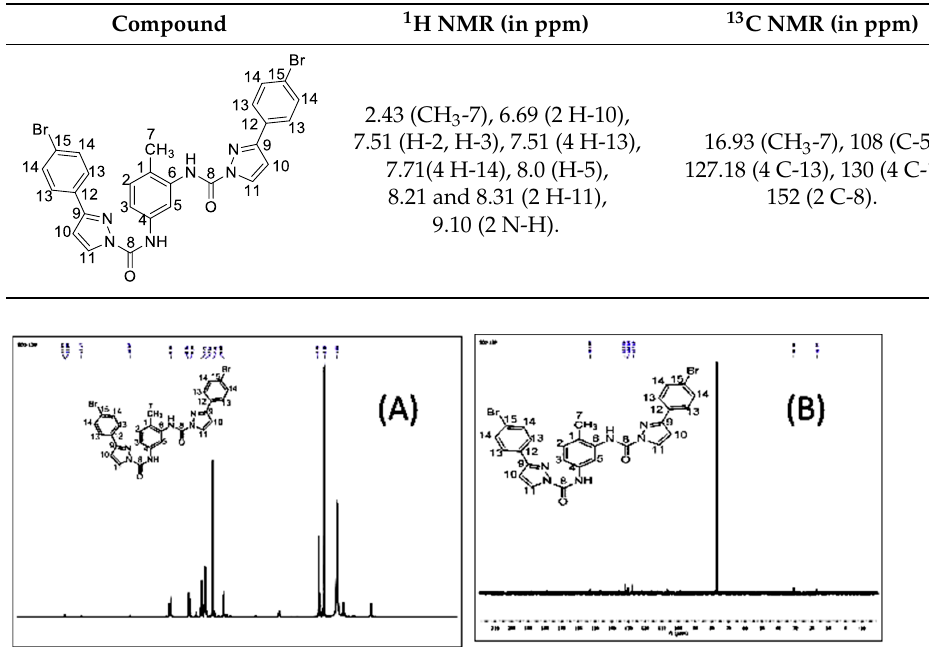
Table 3. NMR spectra of the blocked adduct.